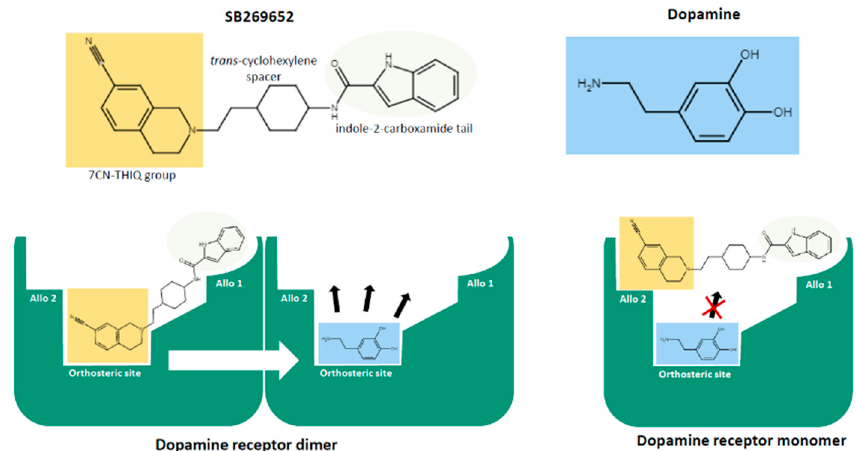
Figure 4. Hypothetical binding mode of SB269652 to dopamine receptor dimer and monomer. SB269652 is composed of three chemical parts, the 7CN-THIQ group, the trans -cyclohexylene spacer in the middle, and the indole-2-carboxamide tail. On the left, SB269652 binds in a bitopic mode to one protomer of the dopamine dimer, the 7CN-THIQ group to the orthosteric site and the indole-2-carboxamide group to the allosteric site (Allo1), to influence dopamine binding on the second protomer (black arrows) through an e ff ect across the dimer (white arrow). On the right, SB269652 binds to the dopamine-occupied receptor and prevents agonist dissociation from the monomer (crossed black arrow). In this last configuration, the 7CN-THIQ group could engage an additional allosteric binding site (Allo2). Diagram was